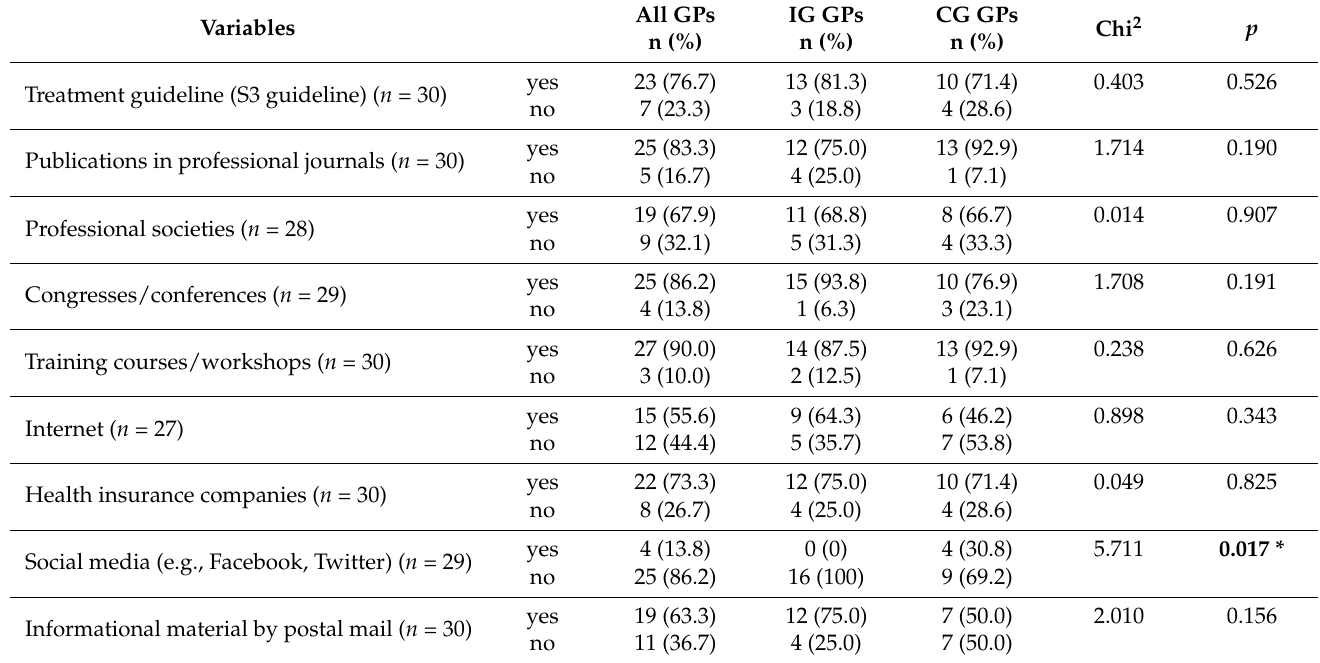
Table 5. Possibilities to increase the level of awareness 1